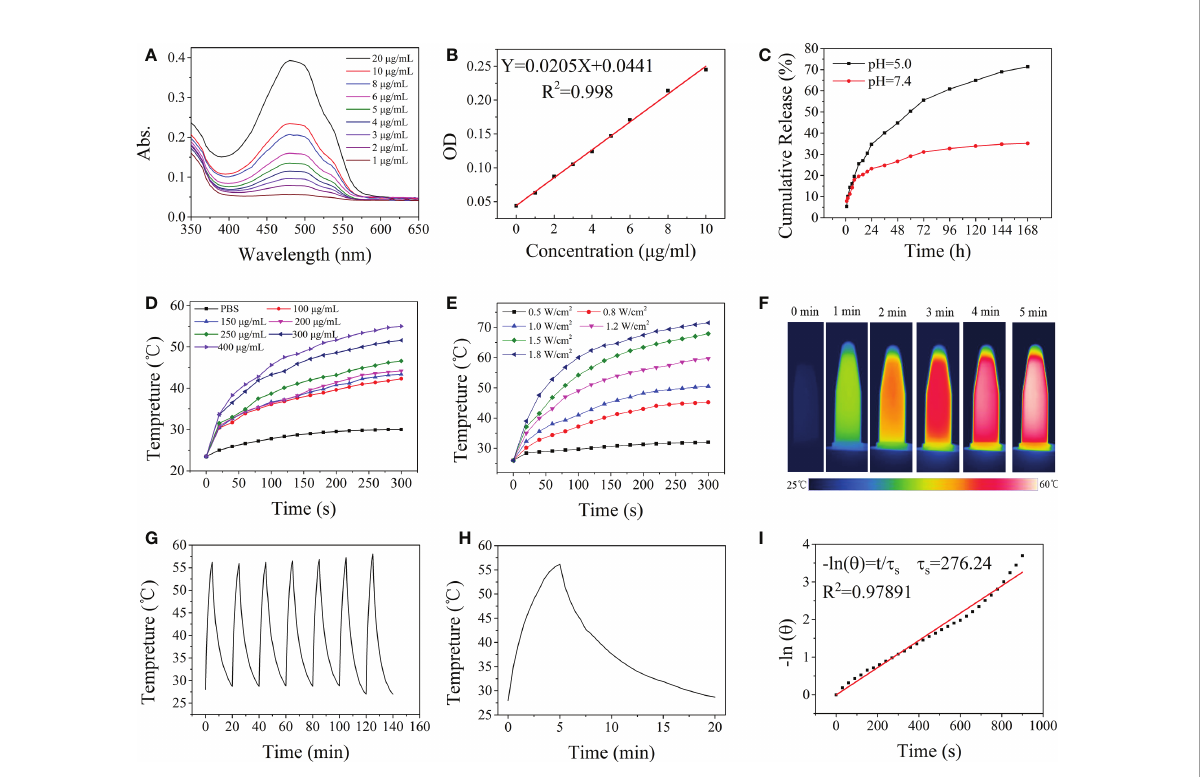
FIGURE 2 Drug release and photothermal properties of nanodrugs. (A) UV-vis absorption spectra of DOX at different concentrations. (B) Fitting curve equation of DOX. (C) In vitro DOX release pro fi le at different pH values of HA-Gd-DOX. (D) The temperature elevation of the HA-Gd with different concentrations. (E) The temperature elevation of the HA-Gd on different powers of laser. (F) Thermal imaging of the HA-Gd with concentrations of 400 m g/ml under an 808-nm laser (1.0 W/cm 2 ). (G) Temperature change of HA-Gd solution at a concentration of 400 m g/ml over seven laser on/off cycles under 808-nm laser irradiation with a power density of 1.0 W/cm 2 . (H) The photothermal conversion results of 400 m g/ml HA-Gd under an 808-nm laser (1.0 W/cm 2 ). (I) Fitted curve of photothermal conversion ef fi